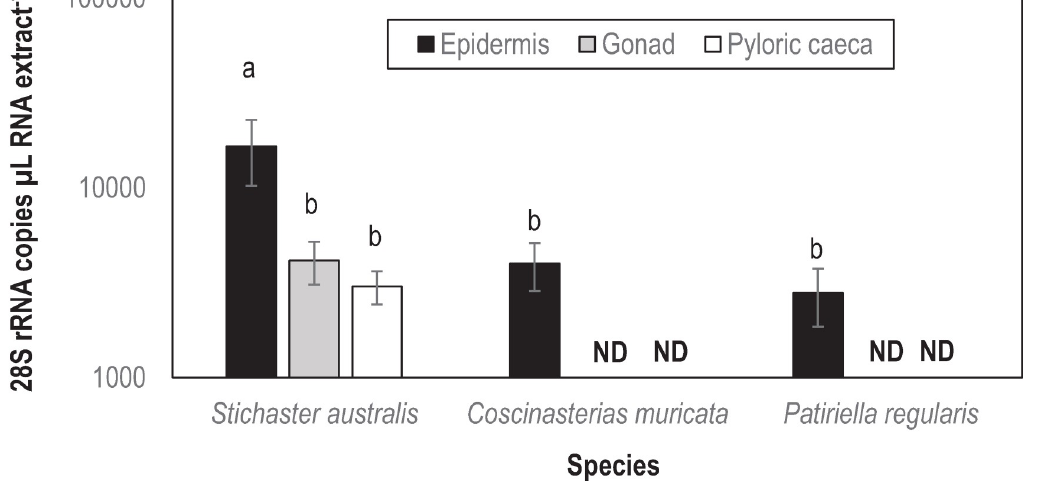
Fig 5. Mesomycetozoan 28S rRNA copies as determined by qPCR in asteroid tissues. a,b denotes significant difference (p < 0.025, Student’s t-test with Bonferroni correction for 2